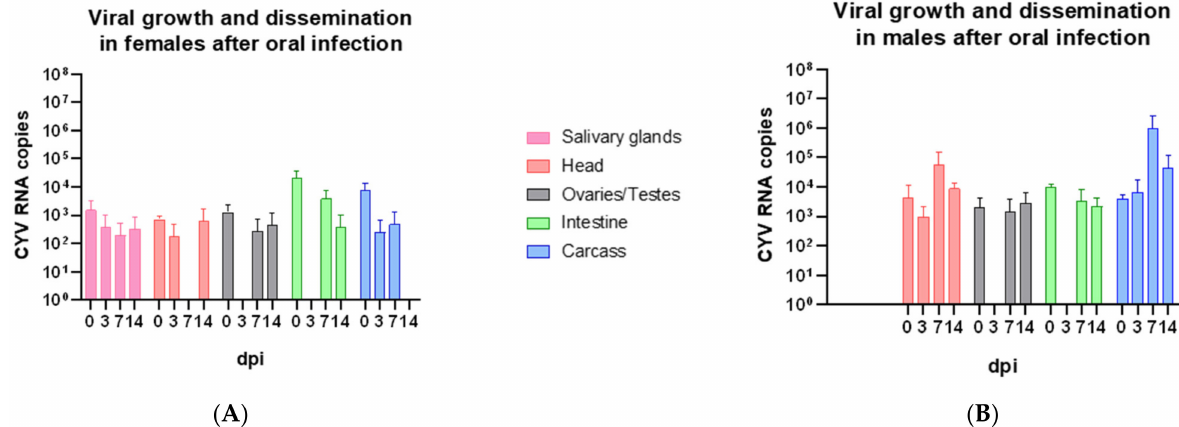
Figure 4. Growth kinetics of CYV in several organs after oral infection in Cx. pipiens biotype molestus . Mosquito dissection and preparation of different organs at zero dpi, three dpi, seven dpi, and fourteen dpi. Organs were washed three times in 1 × PBS. RNA copy numbers per organ per individual are displayed per dissection day with SD. ( A ) Viral growth in females (n = 48); ( B ) Viral growth in males (n = 72). Pink—salivary glands, red—head, grey—ovaries/testes, green—intestine, and blue—body; dpi = days